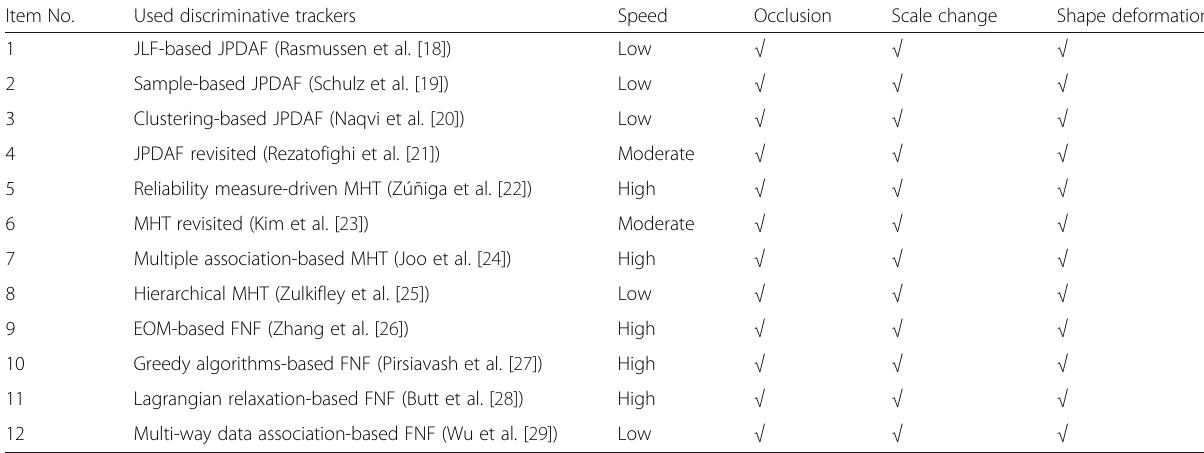
Table 3 Qualitative comparison of discriminative trackers-based human tracking within a camera Item